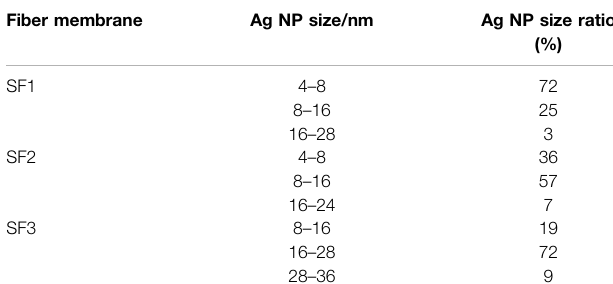
TABLE 1 | Size speci fi c distribution of Ag